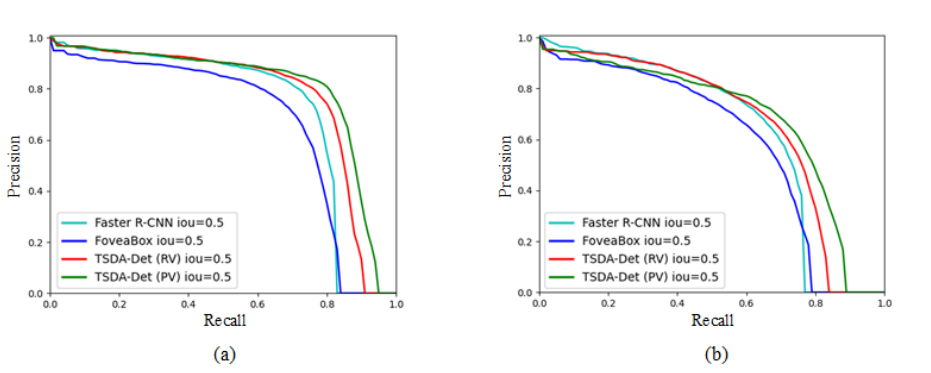
Figure 4. PR curve with IoU = 0.5. ( a ) PR curve of Macrosiphum avenae. ( b ) PR curve of Rhopalosi- phum padi.